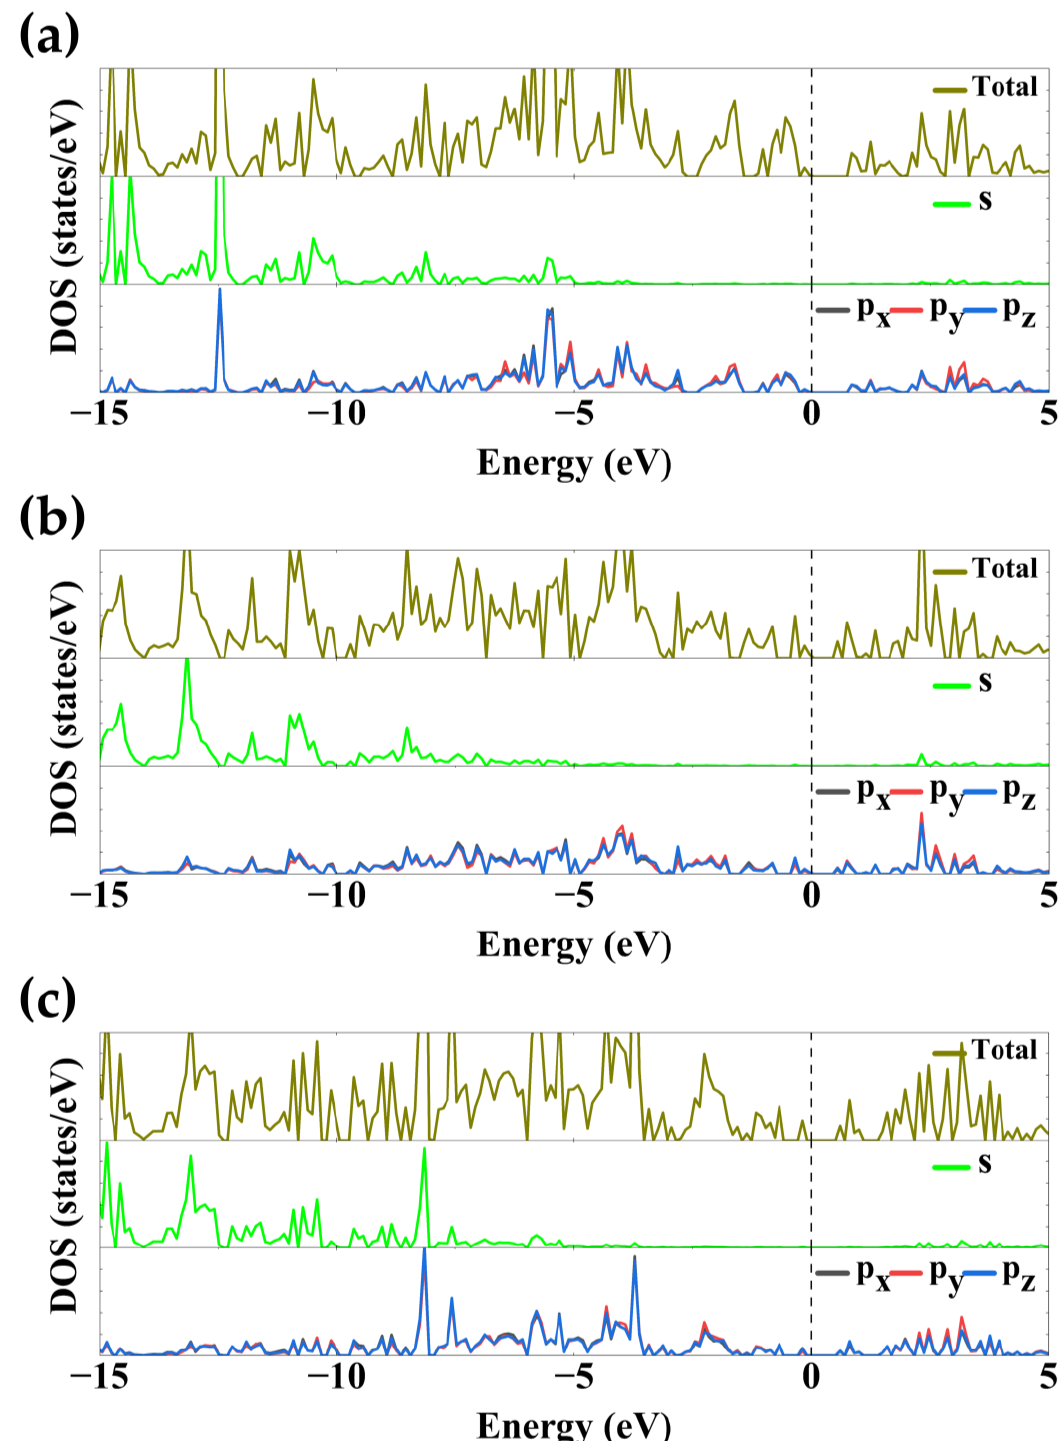
Figure 8. TDOS and PDOS of qhp-C 60 at ( a ) 0 K, ( b ) 300 K, and ( c ) 600 K. Furthermore, we can see that qhp-C 60 has a small bandgap, and its value is approxi- mately 0.7 eV. It is well known that the standard DFT exchange-correlation function greatly underestimates the band gap. For insulators, this is due to the discontinuous existence of energy to electron derivatives. The difference between the calculated and the experimental band gap can reach 0.5 eV [66]. The experimental and calculated values of the band gap of qhp-C 60 are 1.6 eV and 1.2 eV. Based on these facts, the calculated band gap of qhp-C